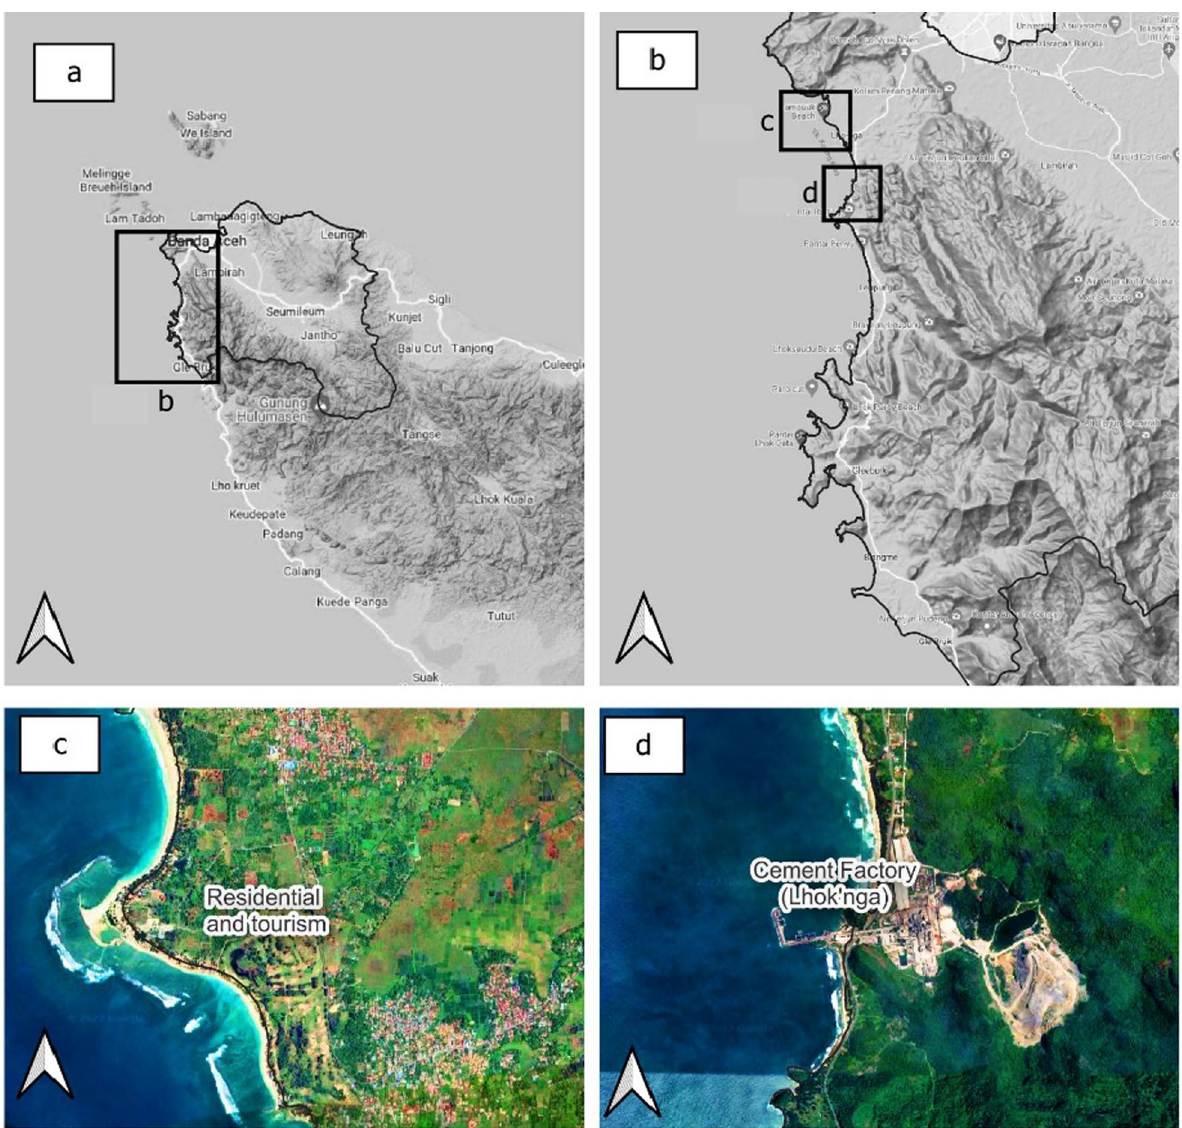
Fig. 1 Maps of the research area’s location; a Aceh Province, b West coast of Aceh Besar, c residence and tourism at Lampuuk and Lhok’nga, d Cement